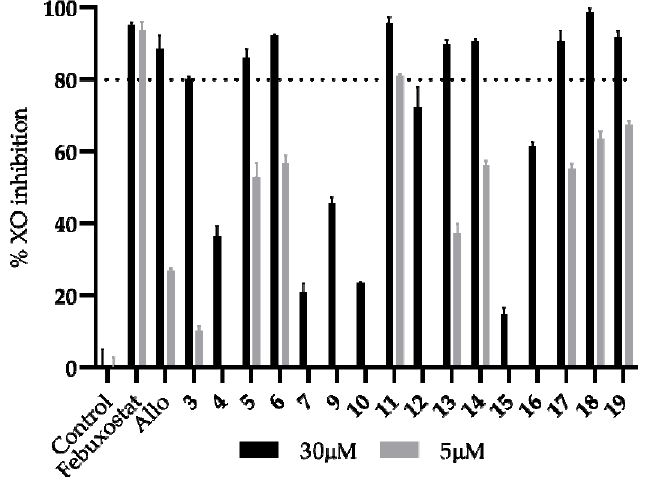
Figure 1. In vitro XO inhibitory activity of bis-thiobarbiturates 3 – 7 and 9 – 19 and references febuxostat and Allo. Results are expressed as average values ± SD of two independent determinations, and each one was performed in triplicate. A p < 0.01 versus the negative control in the statistical significance analysis (Student’s t -test) was observed for all compounds.